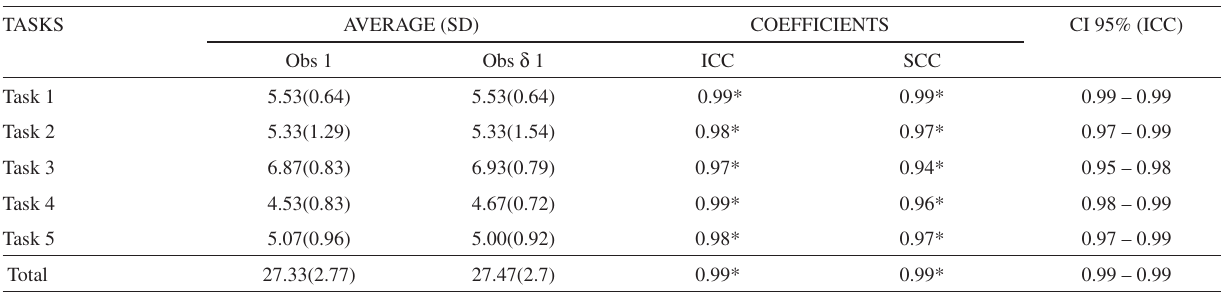
Table 3 - Intra-observer reproducibility according to Spearman’s correlation coefficient (SCC) and intra-class correlation coefficient